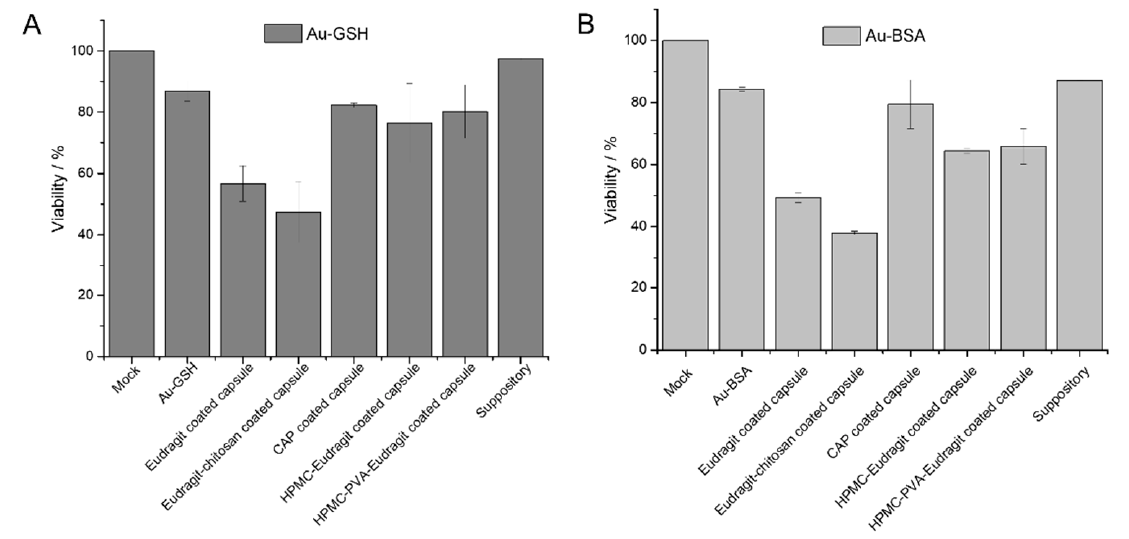
Figure 8. Viability of HeLa cells in the MTT assay in the presence of the components of dissolved enteric-coated capsules and suppositories, previously loaded with Au-GSH nanoparticles ( A ) and Au-BSA nanoclusters ( B ) (mean ± standard deviation; n = 3).